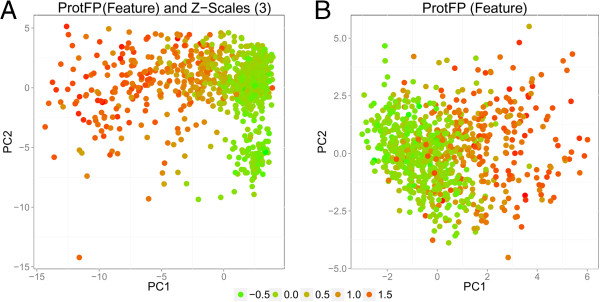
PCA plots of target similarity of the protease mutants. Shown are (A) the best and (B) worst performing descriptor sets. The feature based descriptor only codes for presence or absence of features. This leads to points scattered over a smaller area in PCA space and could explain the decreased performance (B). However, the information is shown to have a synergistic effect when combined with a physicochemical property based descriptor (A).